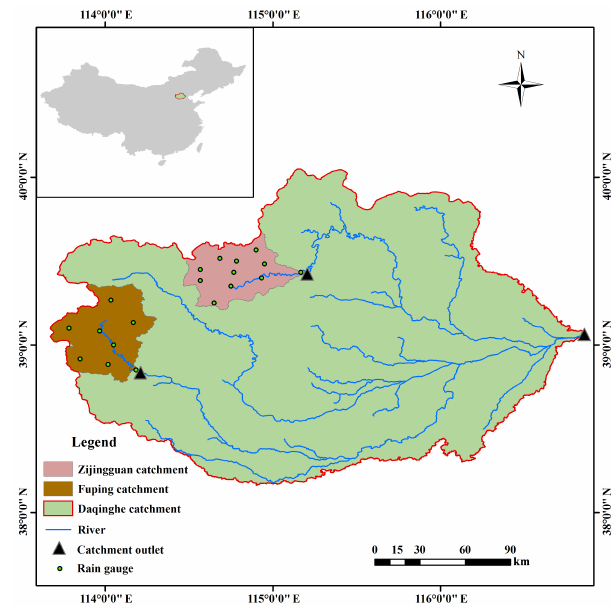
Figure 2. The location of the Daqinghe catchment in northern China (light shading) and the locations of the two study sites in the Daqinghe